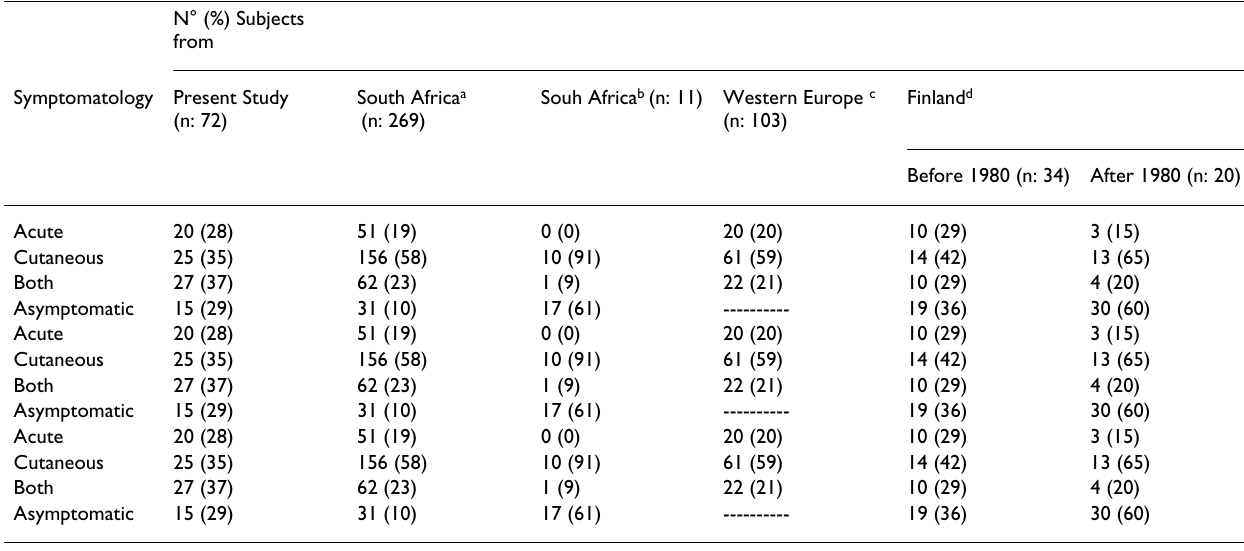
Table 4: Clinical features analysis N° (%) Subjects from Symptomatology Present Study (n: